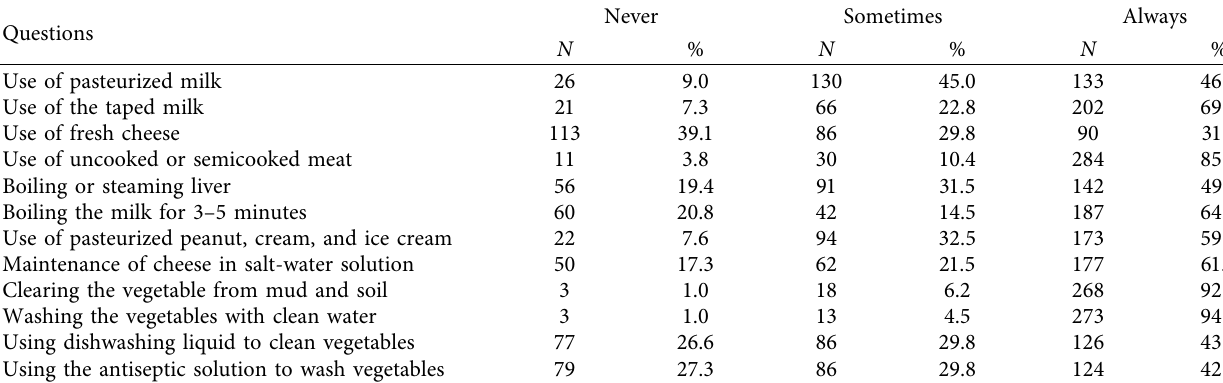
Table 3: Women’s answers to questions about brucellosis prevention behaviors ( n �